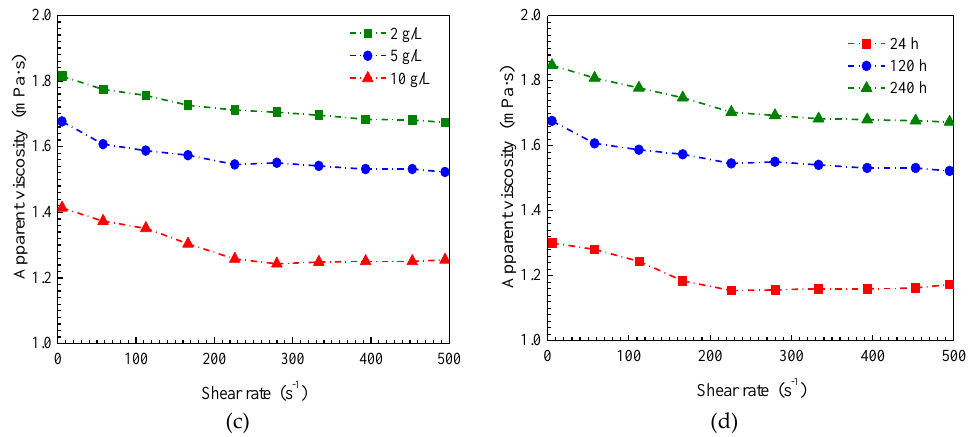
Figure 6. Effect of mass concentration ( a , T = 60 °C, TDS = 5 g/L, and t = 120 h), temperature ( b , C = 1.5 Figure6. E ff ectofmassconcentration( a , T = 60 ◦ C,TDS = 5g / L,andt = 120h), temperature( b ,C = 1.5g / L, g/L, TDS = 5 g/L, and t = 120 h), salinity ( c , T = 60 °C, C = 1.5 g/L, and t = 120 h), and swelling time ( d , TDS = 5 g / L, and t = 120 h), salinity ( c , T = 60 ◦ C, C = 1.5 g / L, and t = 120 h), and swelling time ( d , T = 60 ◦ C, T = 60 °C, C = 1.5 g/L, and TDS = 5 g/L) on rheological properties of SiO 2 /P(MBAAm- co -AM) C = 1.5 g / L, and TDS = 5 g / L) on rheological properties of SiO 2 / P(MBAAm- co -AM) suspension. suspension.